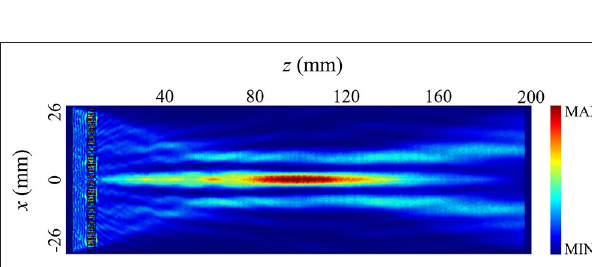
FIGURE 3 | Simulated intensity distribution of generation of a non-diffracting Bessel beam.